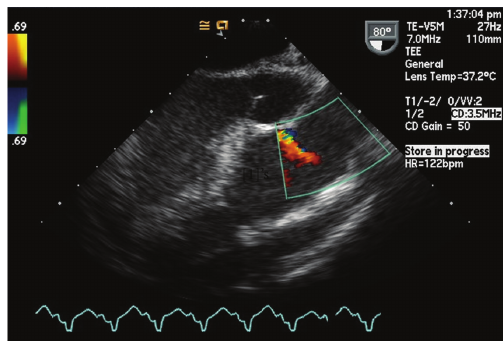
Figure 1: Plasma hemoglobin (mg/dL) following biventricular assist device (BiVAD) implantation.